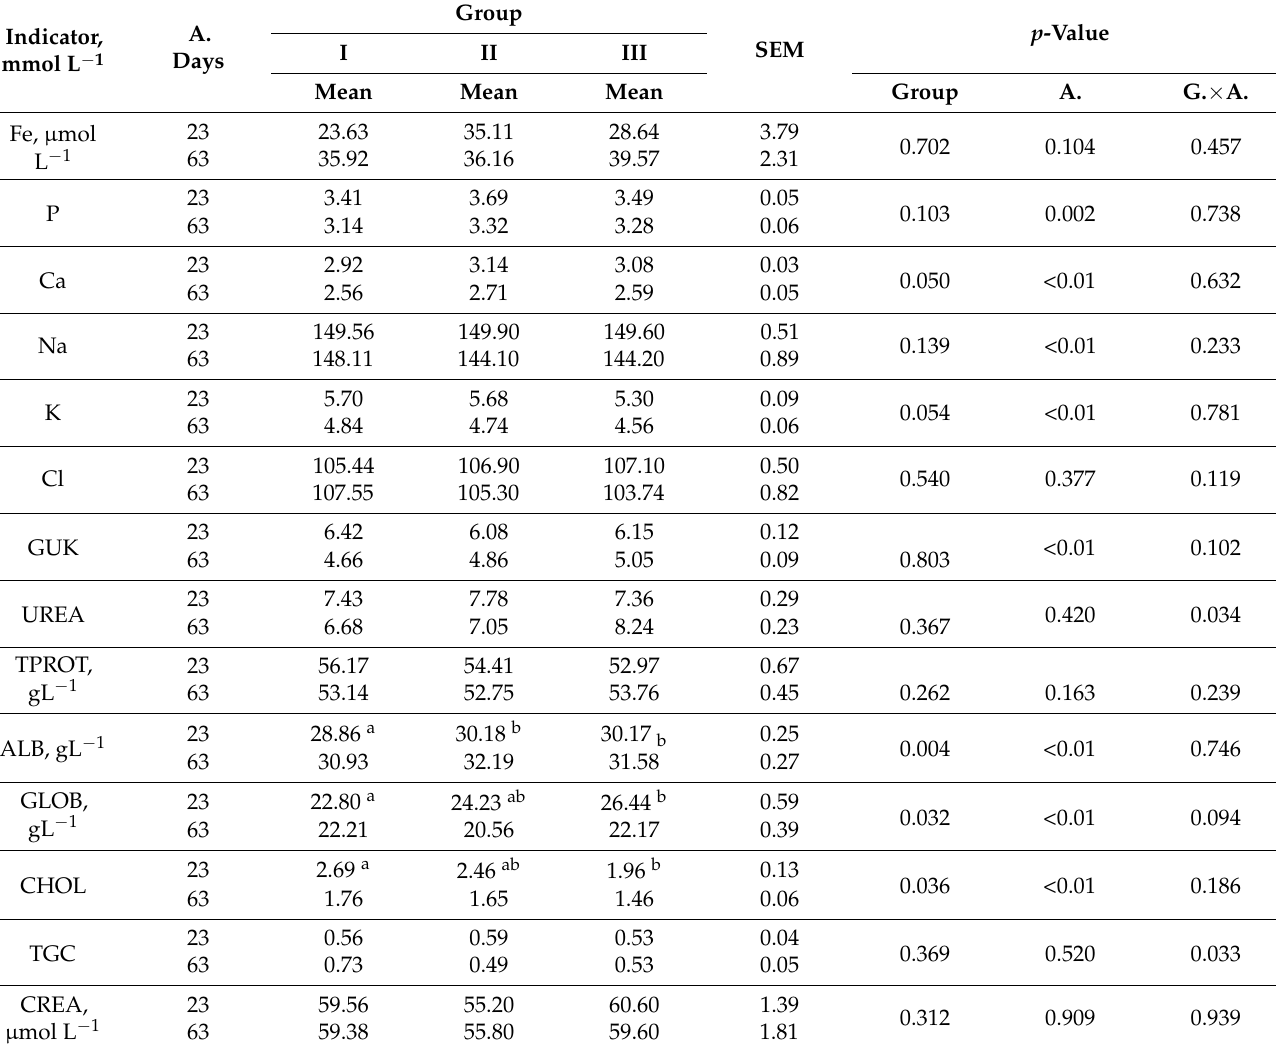
Table 4. Blood biochemical indicators in